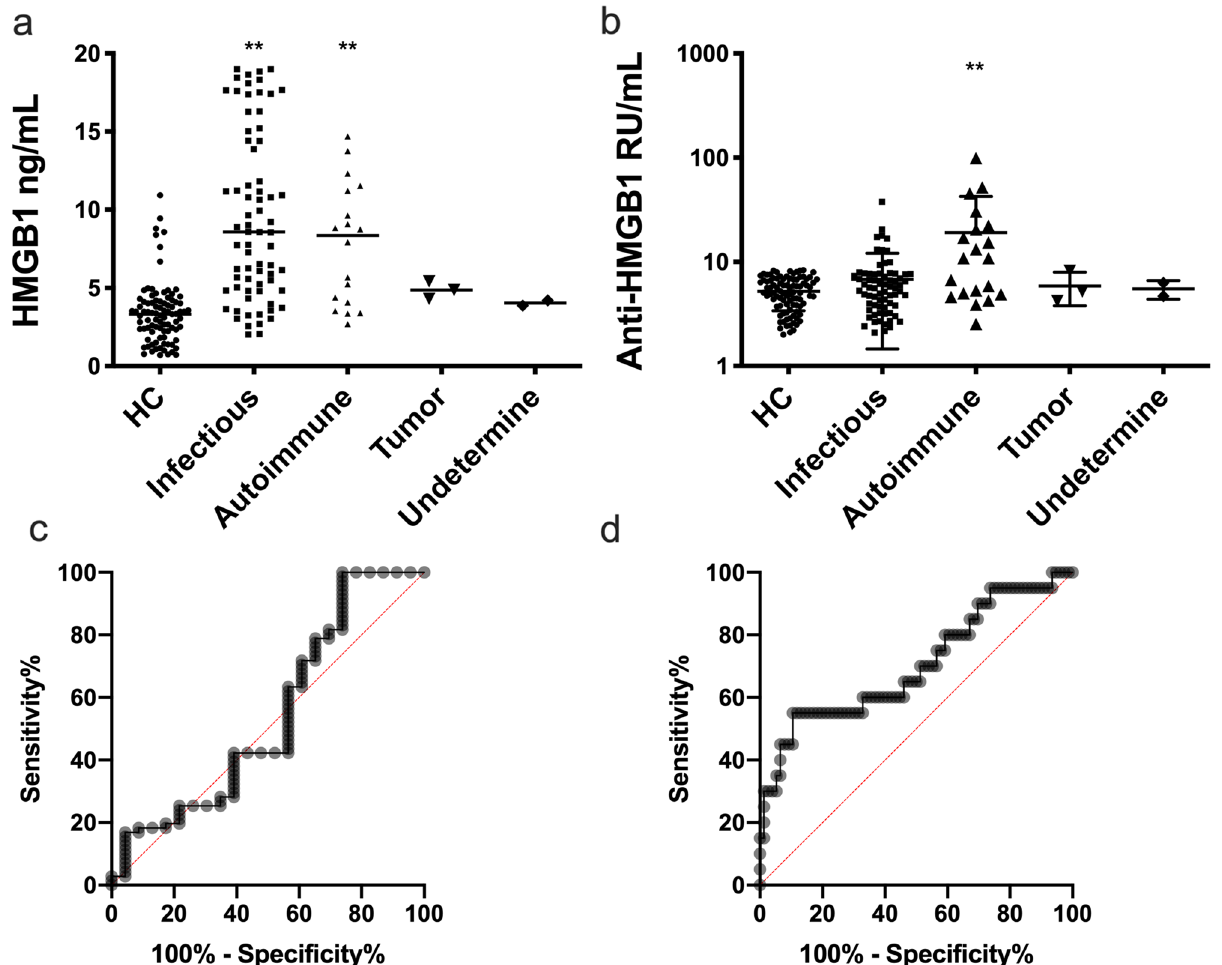
Figure 1. Serum HMGB1 and anti-HMGB1 antibodies in patients with FUO. ( a ) Serum HMGB1 in different subtypes of patients with FUO; ( b ) Serum anti-HMGB1 antibodies in different subtypes of patients with FUO; ( c ) ROC curve of serum HMGB1 in diagnosis of infectious disease subtype in patients with FUO; ( d ) ROC curve of serum anti-HMGB1 antibodies in diagnosis of autoimmune disease subtype in patients with FUO. (* P < 0.05; ** P < 0.01 compared with